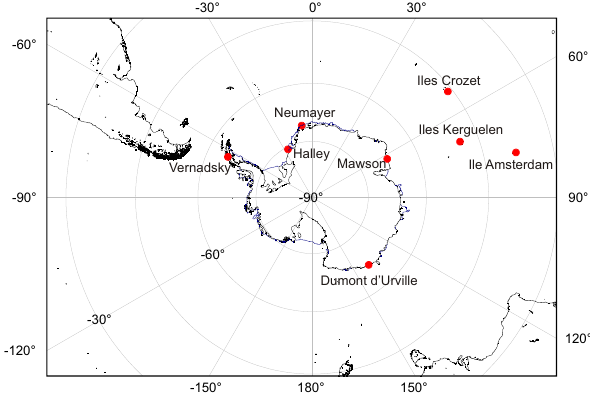
Fig. 1. Map of the high-latitude Southern Hemisphere showing the locations of the measuring sites discussed in the